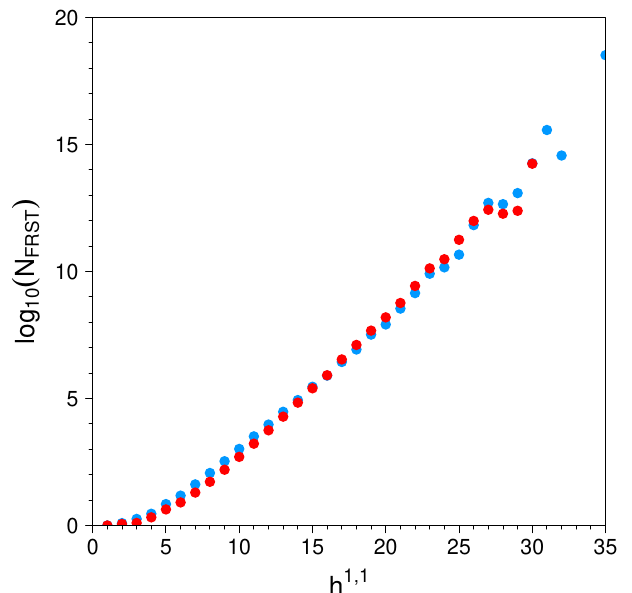
Figure 11 . The mean value of log known facet FRT and FT values (red) .